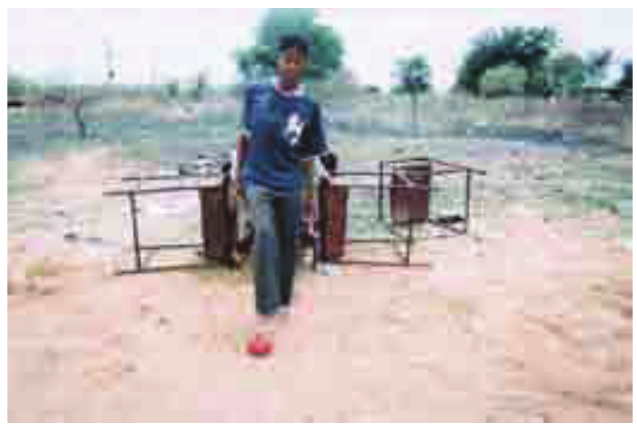
Figure 2: Knowledge’s friend Tshepho in ‘Germany’